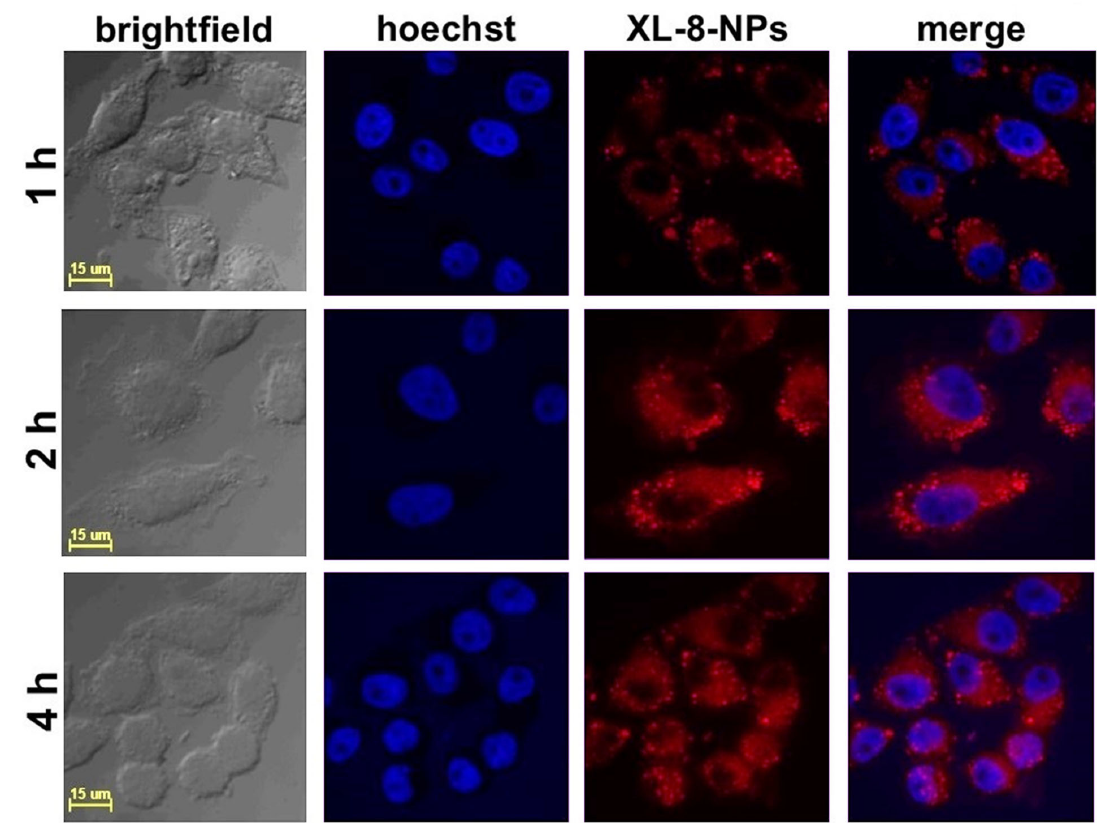
Figure 2. Confocal fluorescence images of HeLa cells treated with XL ‐ 8 ‐ NPs (120 nM) for 1, 2, and 4 h, with hoechst 33,342.